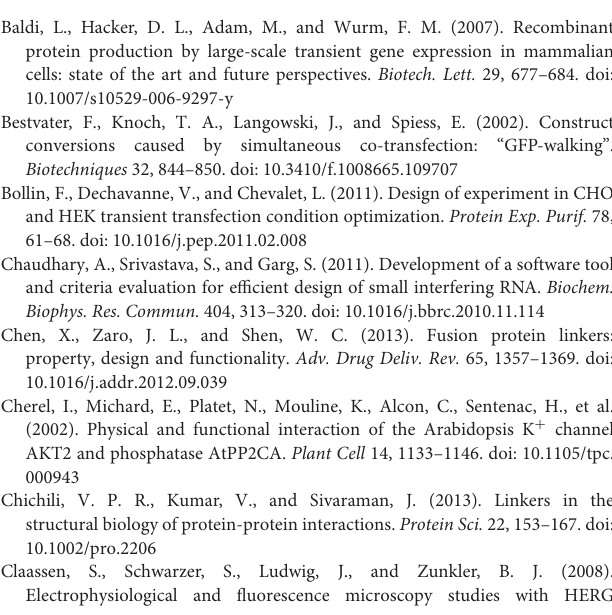
Figure S1 | Design of AtGORK (At5G37500) plasmid construct. (A) Domain organization of full-length Arabidopsis thaliana GORK (AtGORK) (At5G37500) channel and the insertion of the AtGORK gene into pcDNATM6.2/cLumioTM- DEST. (B) Domain organization of full-length Arabidopsis thaliana GORK (AtGORK) (At5G37500) channel and the insertion of the AtGORK gene into Vivid Colors TM pcDNATM6.2/EmGFP-DEST Gateway ® vector. Figure S2 | Comparison of different amount of AtGORK-cLumio TM plasmid for transfection. Figure S3 | mRNA transcript of AtGORK-cLumio TM heterologously expressed in HEK-293 cells. Figure S4 | Experimental workflow for heterologous expression of membrane proteins in HEK-293 cells for electrophysiological characterizations. (A) Plasmid design and label selection. (B) Transfection and expression. (C) Fluorescent imaging and quantification. (D) Current-voltage measurement and data